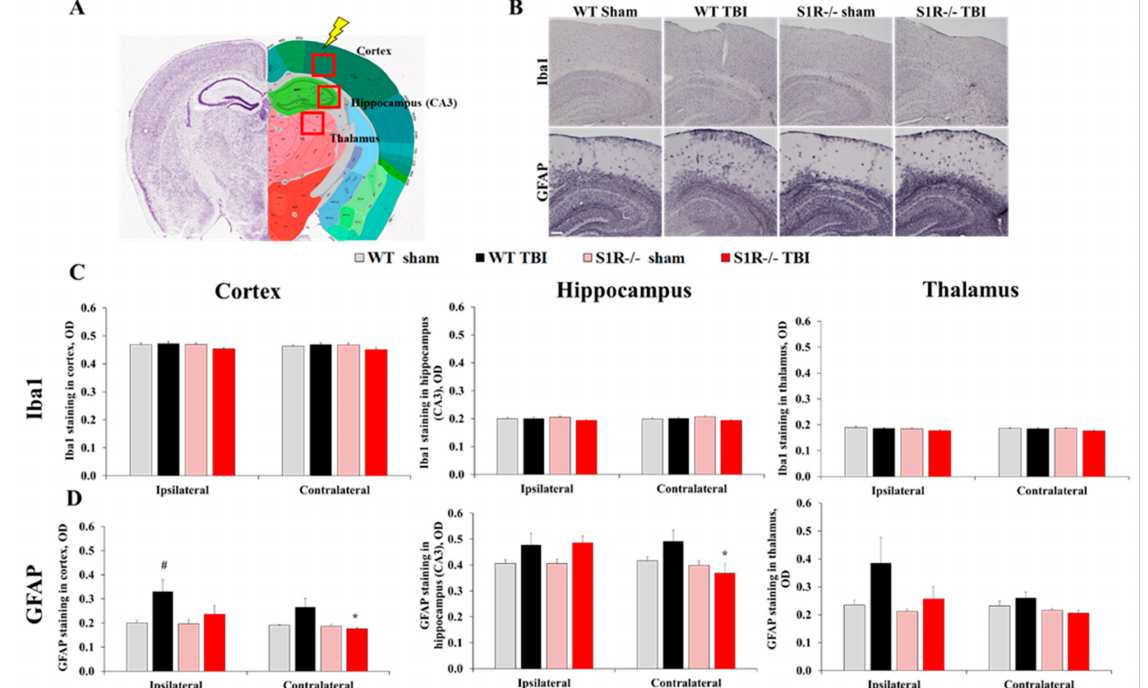
Figure 2. Staining of microglia (Iba1) and astrocytes (GFAP) in WT and S1R-/- mouse brain slices at 12 months postinjury. ( A ) The anatomical positions of the analyzed brain regions were validated using the Allen Mouse Brain Atlas (http: //mouse.brain-map.org/static/atlas, accessed on 15 October 2021). ( B ) Representative images of Iba1 and GFAP staining in the cortex and hippocampus (total magnification = 40 × , scale bar = 100 µ m). Measured optical densities (OD) of the